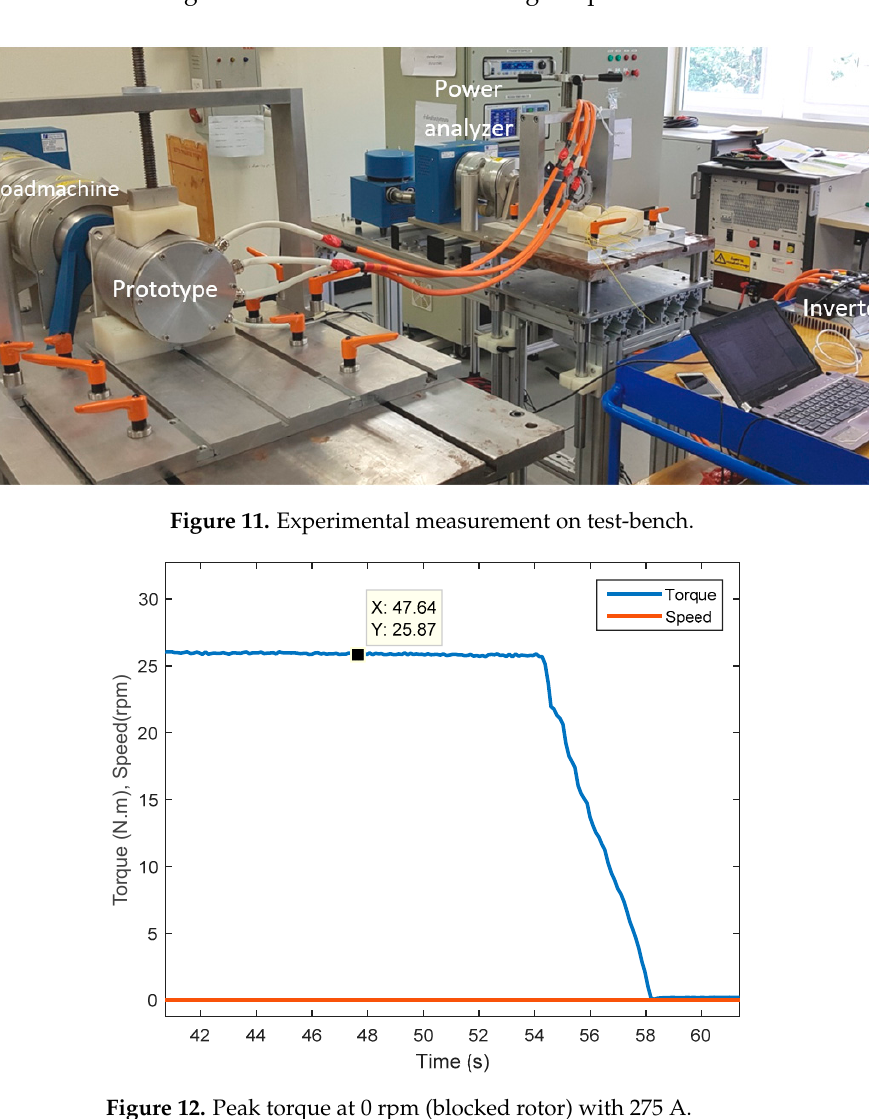
Figure 12. Peak torque at 0 rpm (blocked rotor) with 275 A.